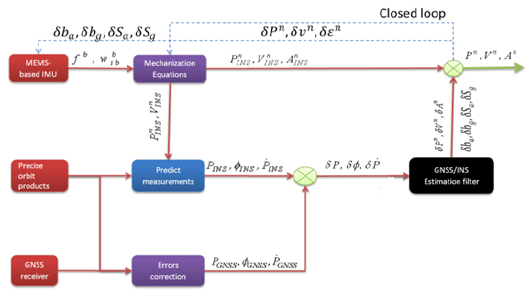
Figure 1. Tightly coupled GPS-PPP/INS